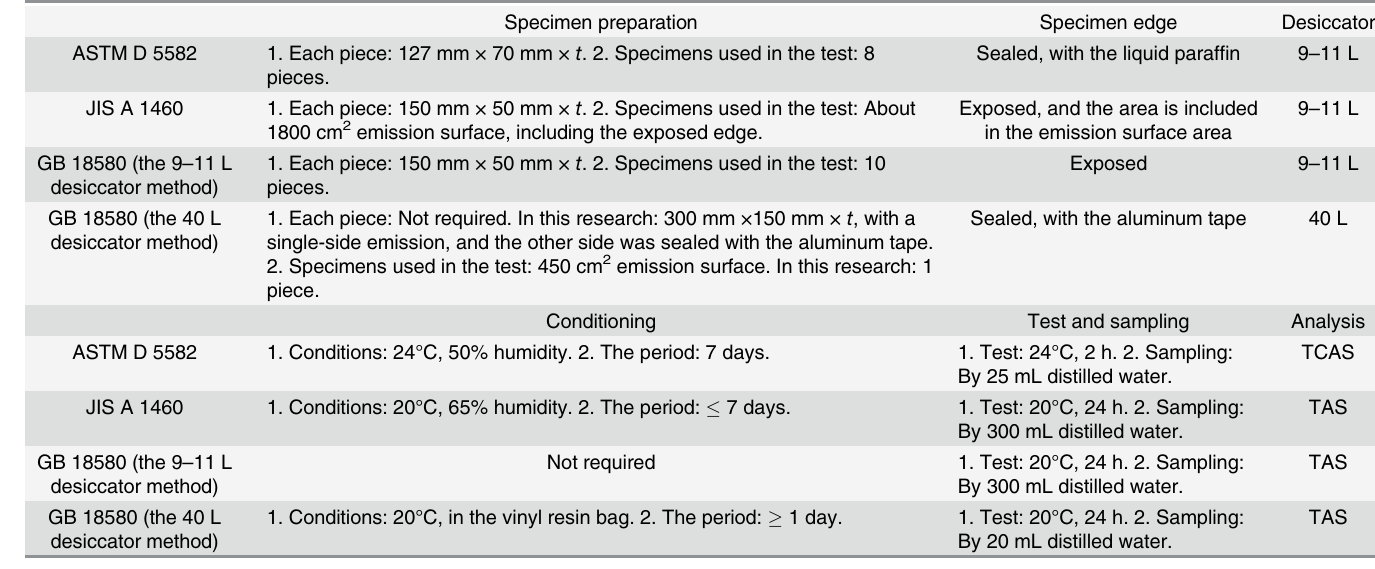
Table 3. Characterization of the Product Formaldehyde Emission: The Desiccator Methods in Popular Standards and Chinese GB 18580. Specimen